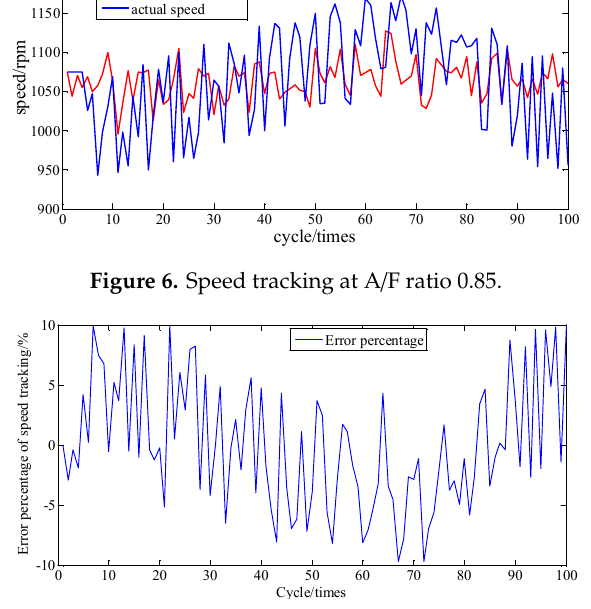
Figure 7. Error percentage of speed tracking at A/F ratio 0.85.